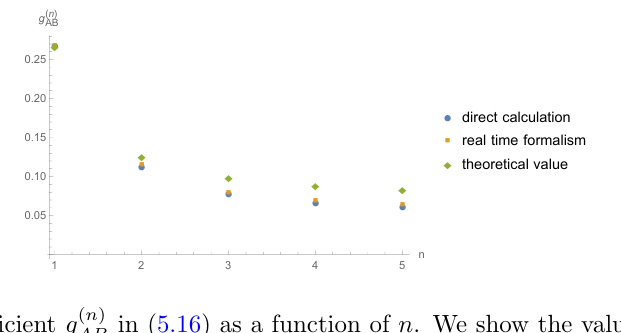
Figure 2 . The coe(cid:14)cient g ( n ) in (5.16) as a function of n . We show the values of g ( n ) AB by the direct calculation developed in this paper and the real time formalism, and the theoretical values g ( n ) j d =3 AB